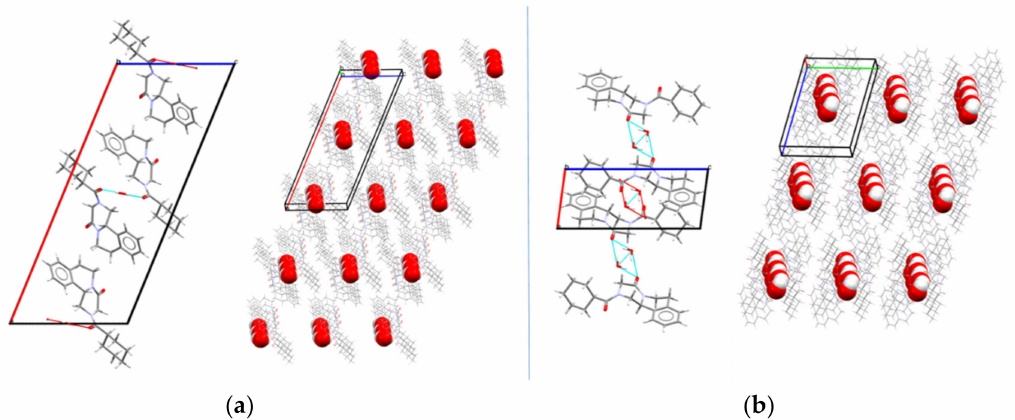
Figure 4. Packing and hydrogen bonds motifs between PZQ and water molecules in ( a ) the enantiomeric hemihydrate SIGBUG [15] and ( b ) in the new racemic hemihydrated form.